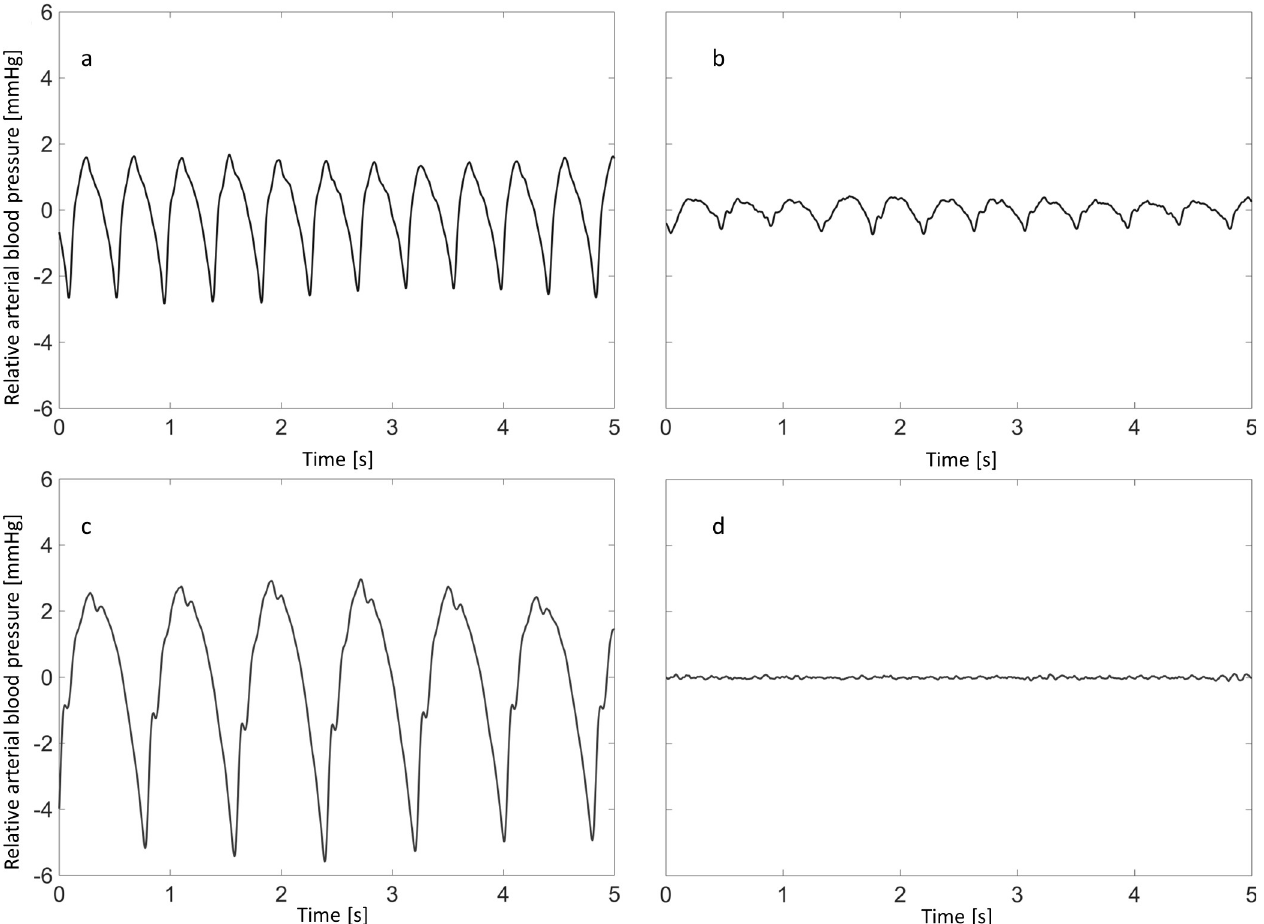
Fig 1. Arterial pulse wave proximal and distal to the clot. Upper row (a and b): case with maintained arterial pulse wave. Pressure curves before (a) and behind (b) the clot. Mean arterial pressure and pulse pressure before (a) and behind (b) the clot are 100 mmHg and 86 mmHg and 4.4 mmHg and 0.5 mmHg, respectively. Lower row (c and d): case with loss of arterial pulse wave. Pressure curves before (c) and behind (d) the clot. Mean arterial pressure and pulse pressure before (c) and behind (d) the clot are 98 mmHg and 10 mmHg and 7.3 mmHg and 0 mmHg, respectively.